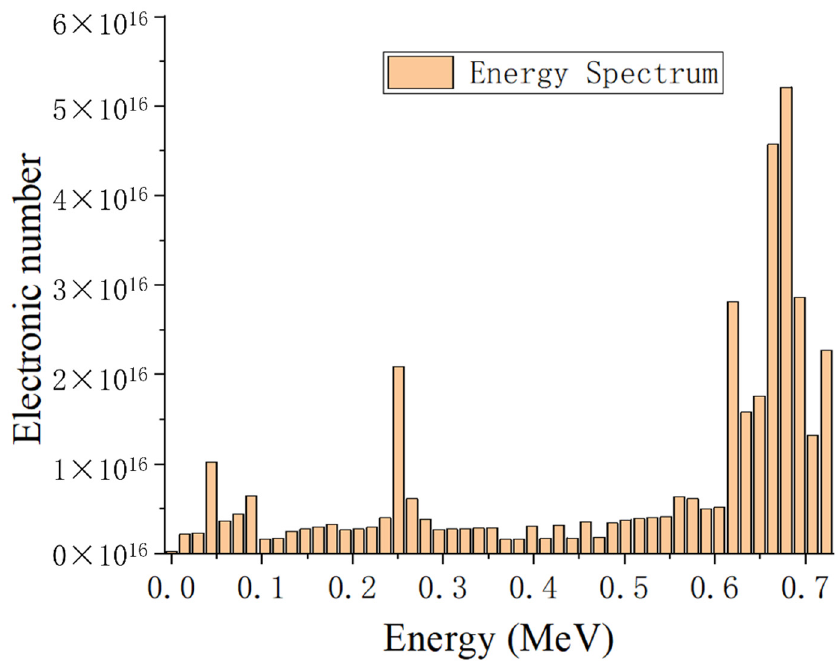
Figure 7. Multi-spectrum electron beam spectrum waveform (No. 21040).